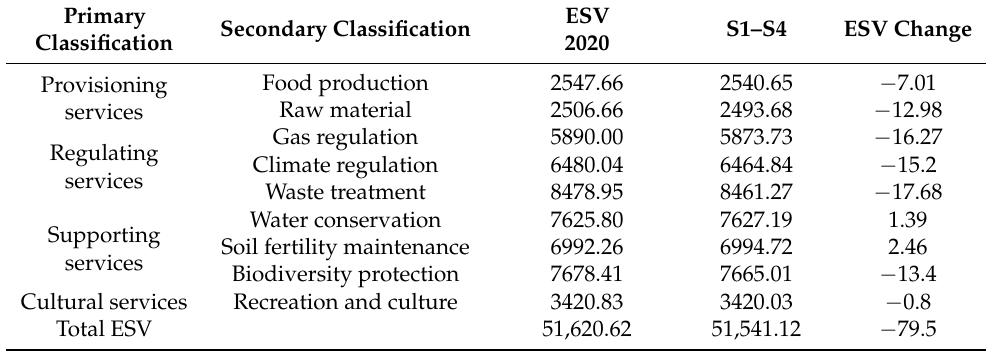
Table 5. Predicted results of ESV in 2035 compared to that in 2020 ( × 10 6 yuan. yr − 1